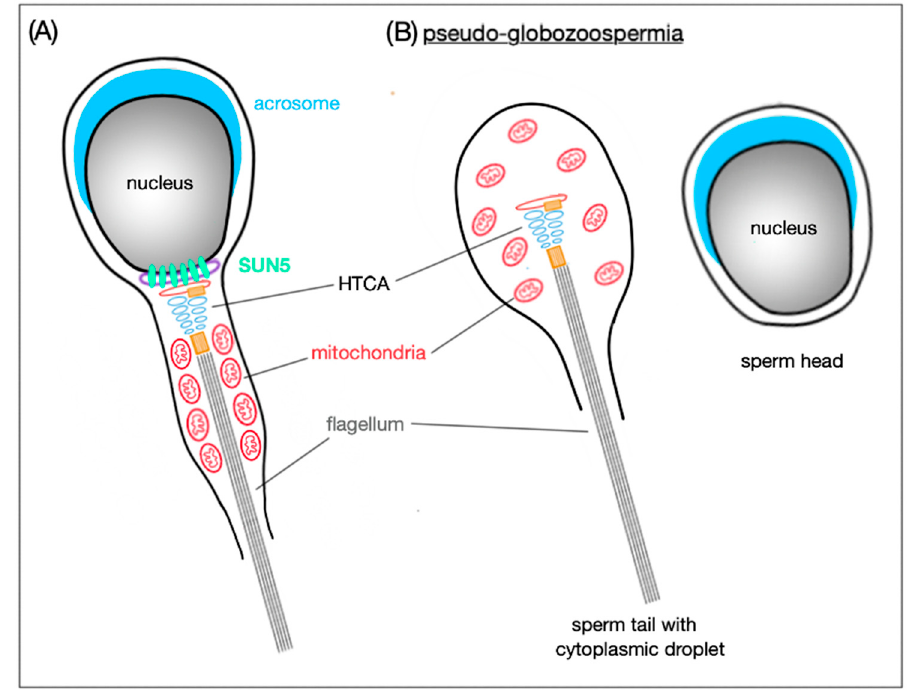
Figure 4. Schematic representation of SUN5 function in mature spermatozoa. ( A ) SUN5 is localized to the very posterior pole of the sperm head where it connects it to the tail. ( B ) In the absence of SUN5, the sperm head detaches completely from the sperm tail; this results in release of decapitated sperm tails with only cytoplasmic droplets in the lumen of seminiferous tubules. This phenomenon is also called